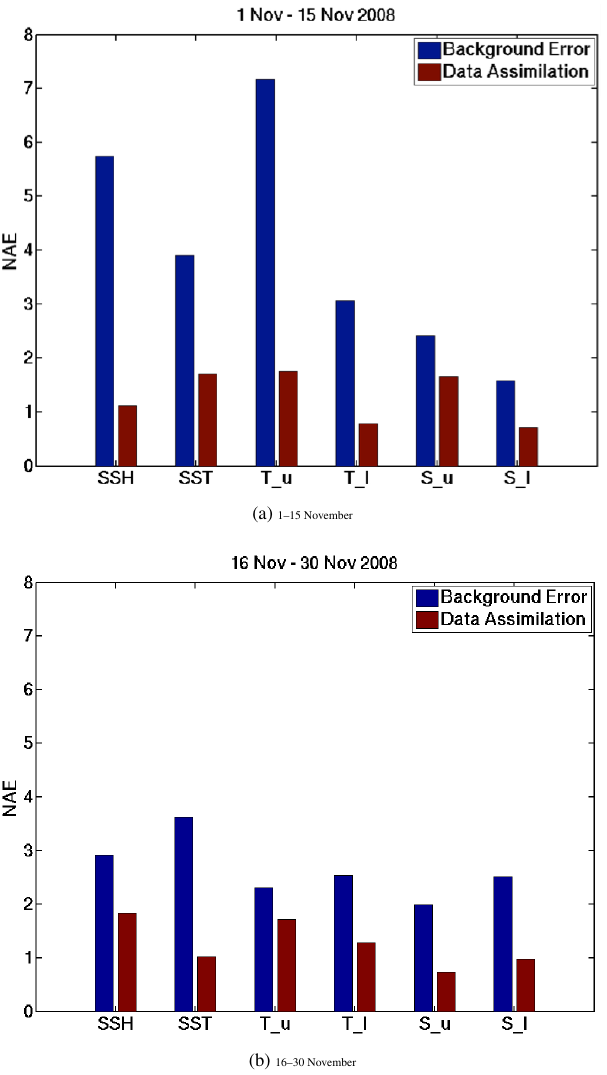
Fig. 3. Normalized mean absolute error changes for the two 15 day Fig. 3: Normalized mean absolute error changes for the two 15 day assimilation fits. (a) For the first assimilation fits. (a) For the first 15 day fit for 1–15 November 2008. 15 day fit for 1–15 November 2008. (b) For the second 15 day fit for 16–30 November 2008 for sea (b) For the second 15 day fit for 16–30 November 2008 for sea surface height (SSH), sea surface temperature (SST), temperature in surface height (SSH), sea surface temperature (SST), temperature in upper 100 m (T u), temperature upper 100m ( T u ), temperature below 100m ( T l ), salinity in upper below 100 m (T l), salinity in upper 100 m (S u) and salinity below 100 m (S l). 100m ( S u ) and salinity below 100m ( S l ).